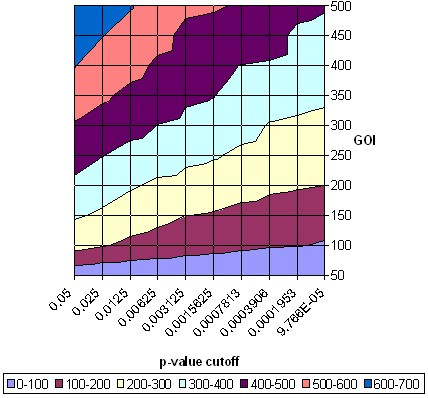
Overhead view of surface topology for the portion of the S. cerevisiae data set. Different colors represent different numbers of significant terms.